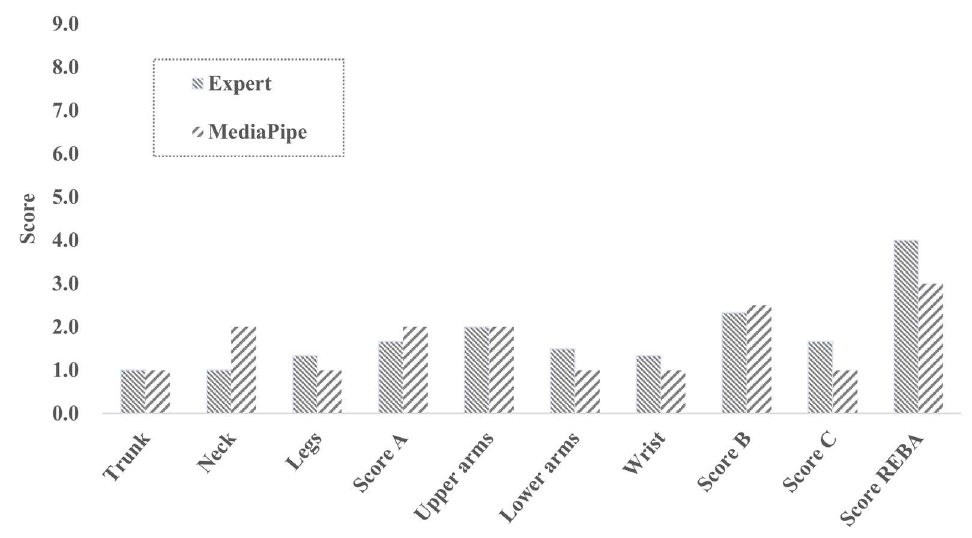
Figure 36. Comparison of circular saw working posture scores.